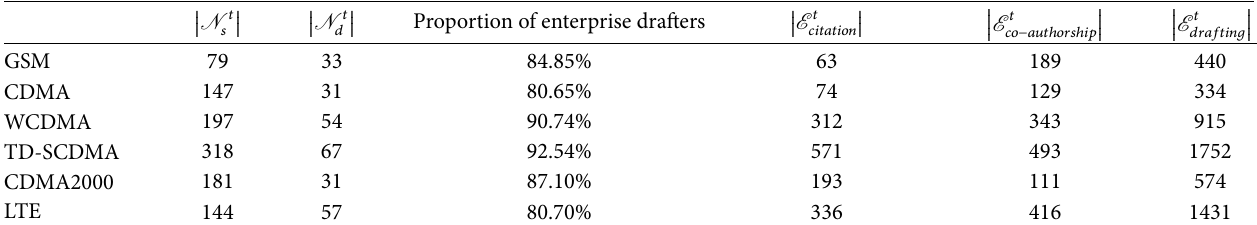
Table 12: Comparison of network indicators between different communications-technology systems.